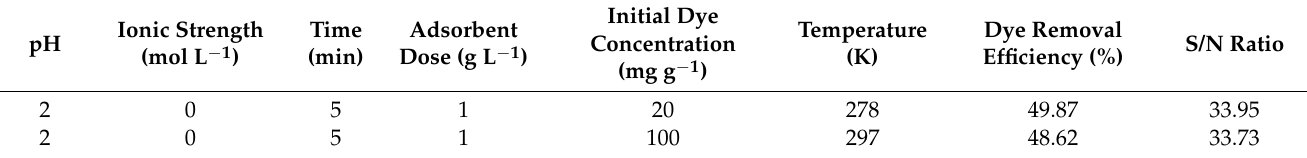
Table 5. The L27 orthogonal array used in the Taguchi